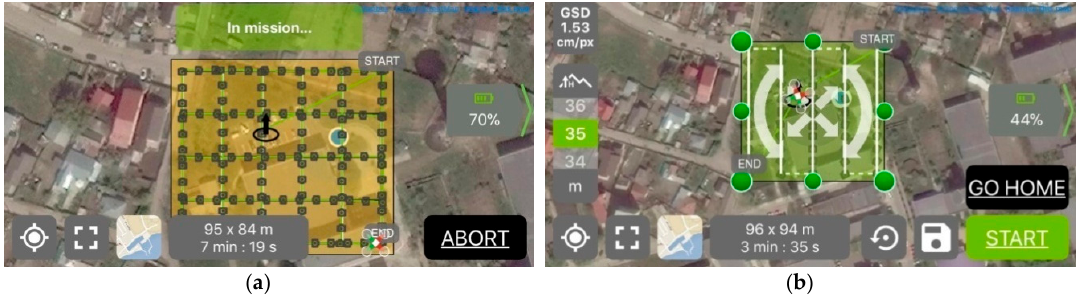
Figura 14. Taking the UAS images over the calibration field at ( a ) 28 m and ( b ) 35 m.